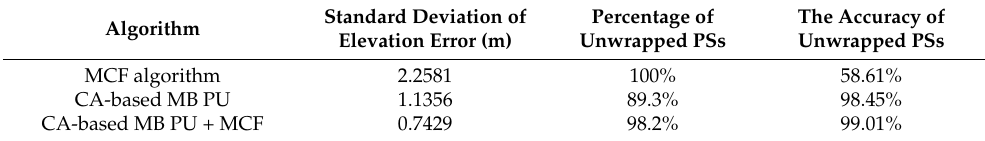
Table 3. Different algorithms’ processing